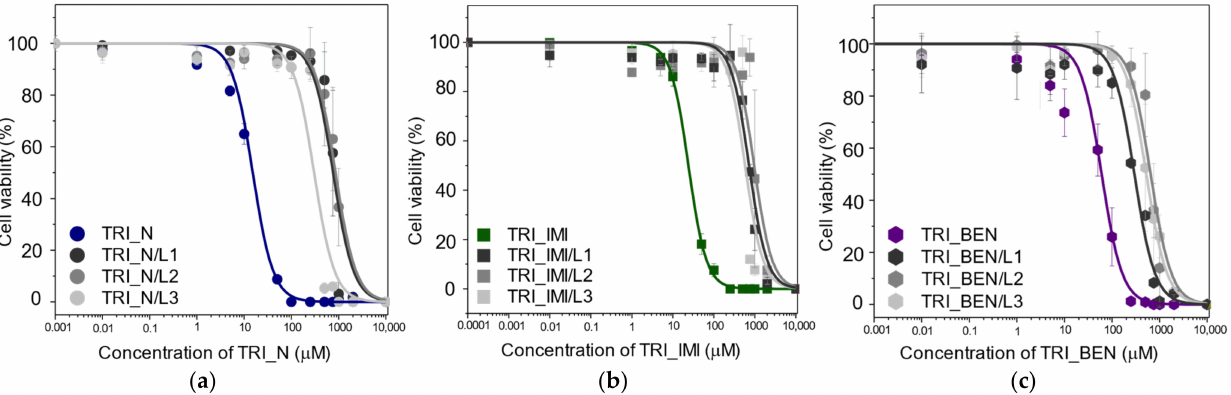
Figure 9. The results of the MTT assay after HeLa cells incubation with surfactants and surfactants and lipids mixtures (L1– L3) at increasing concentrations. ( a ) dose response curve showing of TRI_N, ( b ) TRI_IMI, and ( c ) of TRI_BEN based